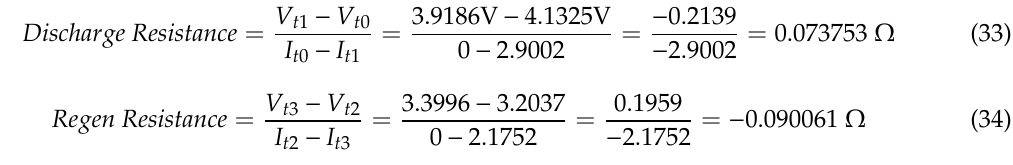
Table 3. Hybrid pulse power characterization (HPPC) test profile table for battery cell1.